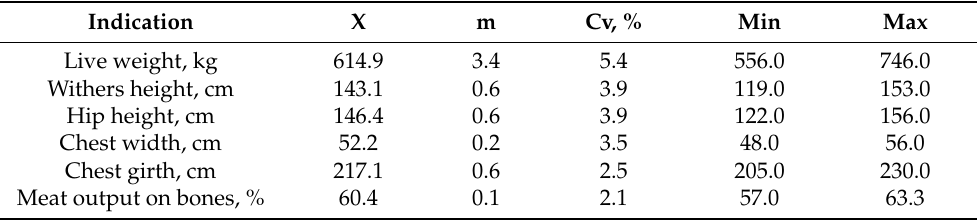
Table 1. Characteristics of exterior features, fattening, and meat productivity of a sample of Aberdeen- Angus breed animals.